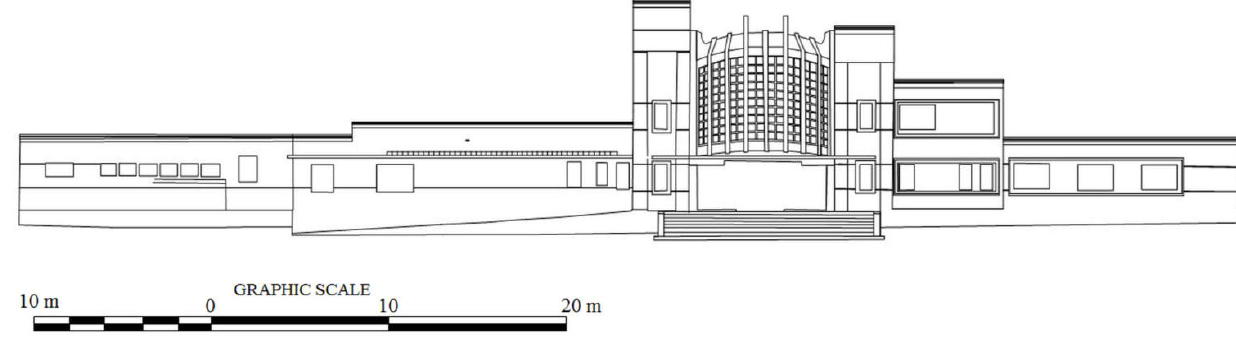
Figure 4. Presidente Prudente Railway Station